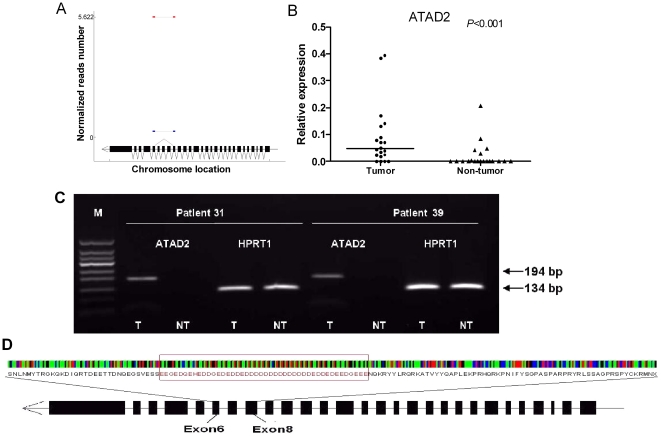
Analysis and confirmation of a differently expressed novel exon-exon junction identified for the ATAD2 gene.(A) A schematic diagram of the differently expressed novel junction in ATAD2. Red line represents tumor tissues and blue line represents adjacent non-cancerous tissues. The structure of gene was plotted at the bottom. The connecting lines below exons represent all known annotated junctions. The red connecting line above exons represents the predicted novel exon-exon junction. (B) Relative expression of the novel junction of ATAD2 in HCC and non-cancerous tissues. (C) RT-PCR analysis on agrose gel electrophoresis for the novel junction in HCC and non-cancerous tissues from 2 HCC patients. HPRT1 was used as the internal control. (D) A schematic diagram of amino acid sequence for exon 6–8 in ATAD2 gene.